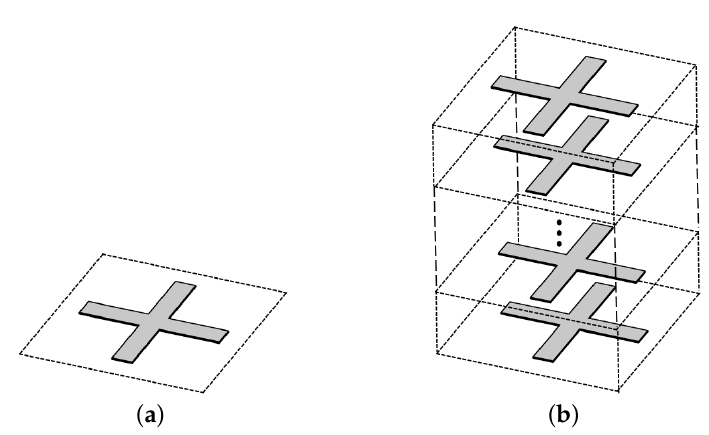
Figure 7. Electromagnetic surfaces with ( a ) single-layer structure ( b ) multiple-layer structure.